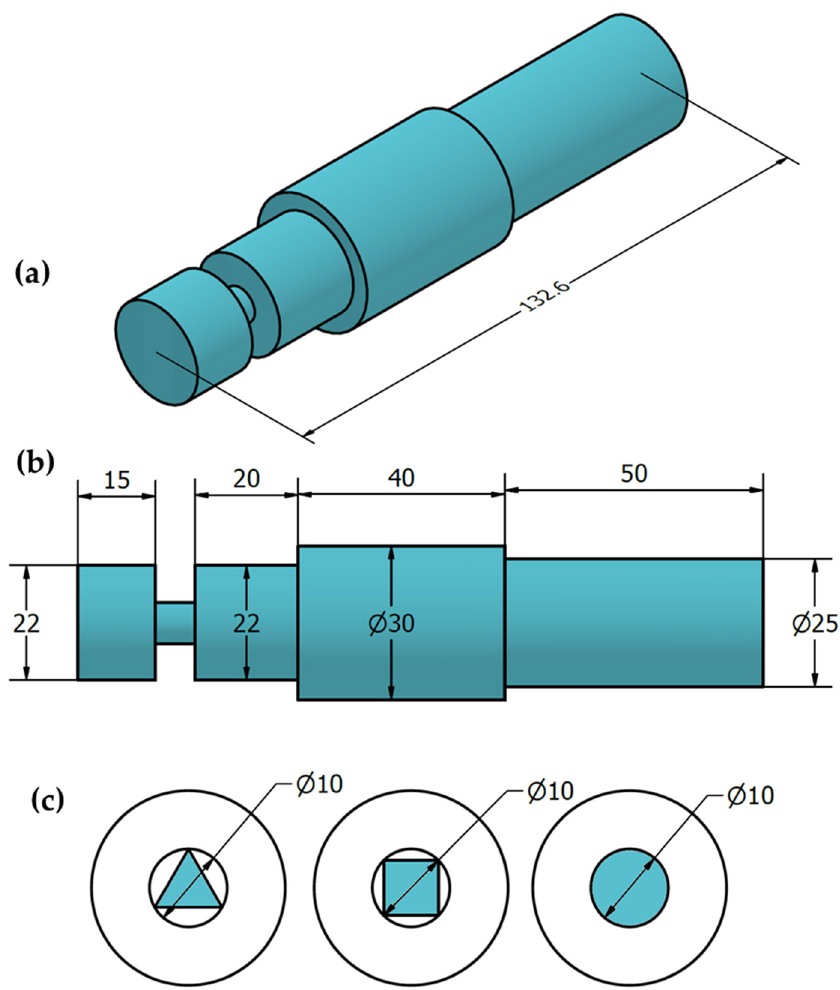
Figure 2. ( a ) Three-dimensional drawing and ( b ) dimensions of the applied BT, and ( c ) the used different pin geometries. (Unit: mm)